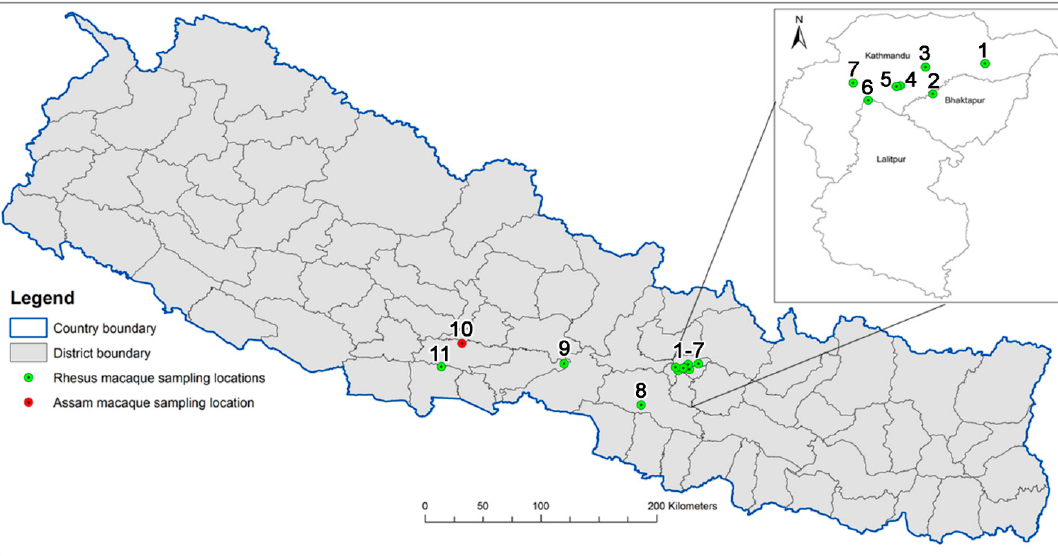
Figure 1. Primate Sampling Locations . Saliva Sampling was conducted at 11 locations in Nepal: 1-Bajrayogini; 2-Nilbarahi; 3-Gokarna; 4-Guheswari; 5-Pashupati; 6-Thapathali; 7-Swayambhu; 8-Hetauda; 9-Chitwan; 10-Ramdi; 11-Rupandehi.